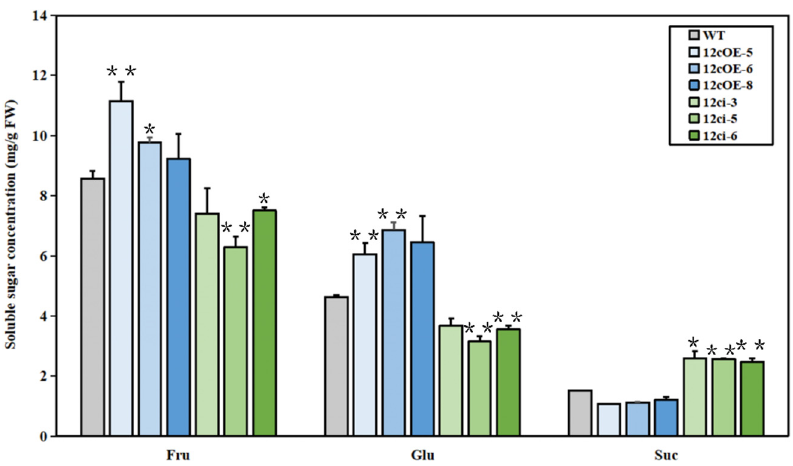
Figure 6. Soluble sugar content in RR fruits of WT, SlSWEET12c OE, and RNAi lines. Suc—sucrose; Glu—glucose; Fru—fructose. Statistical significance is indicated by * ( p < 0.05) and ** ( p < 0.01); n ≥ 20. FW—fresh weight. Every experiment was repeated at least three times.